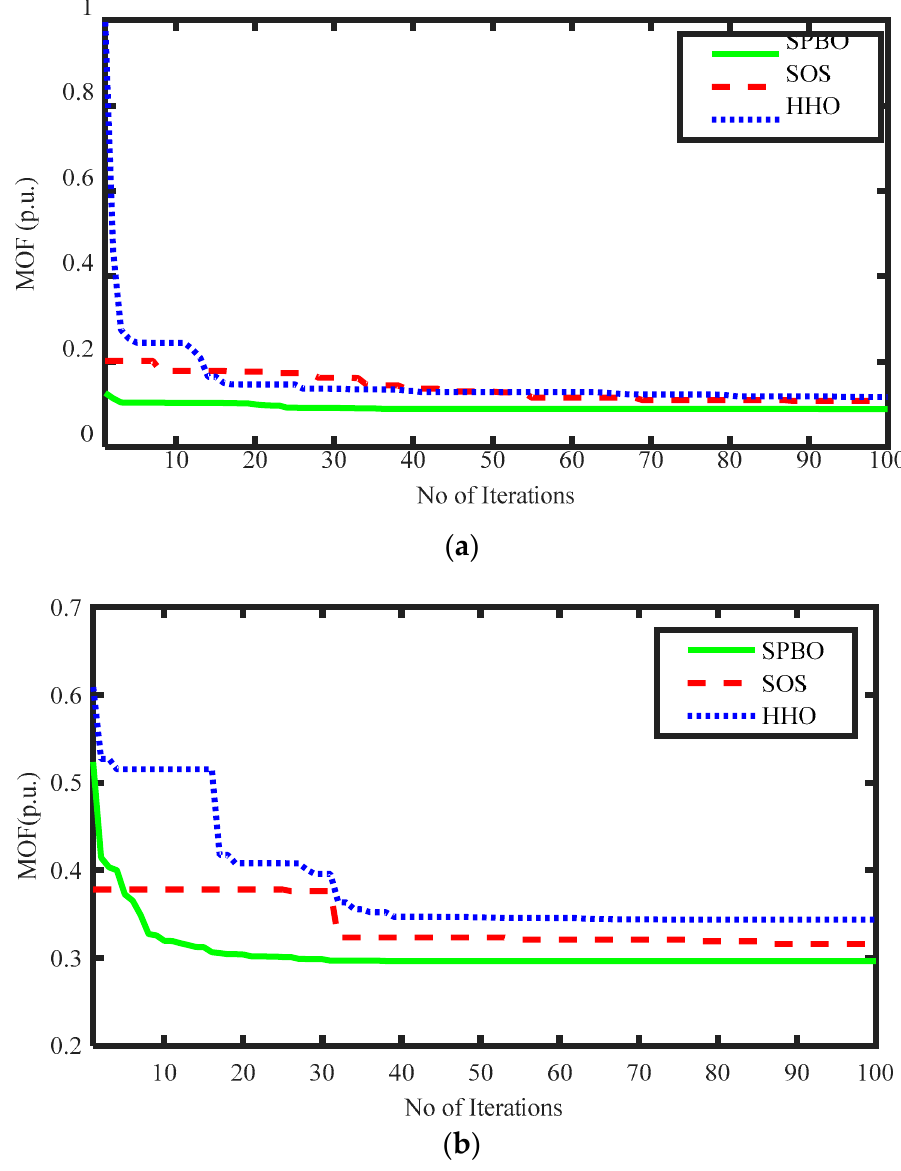
Figure 9. CC of optimization algorithms for case-8. ( a ) 33-bus test system; ( b ) 118-bus test system. Table 17. Statistical performance of different methods for 33-bus